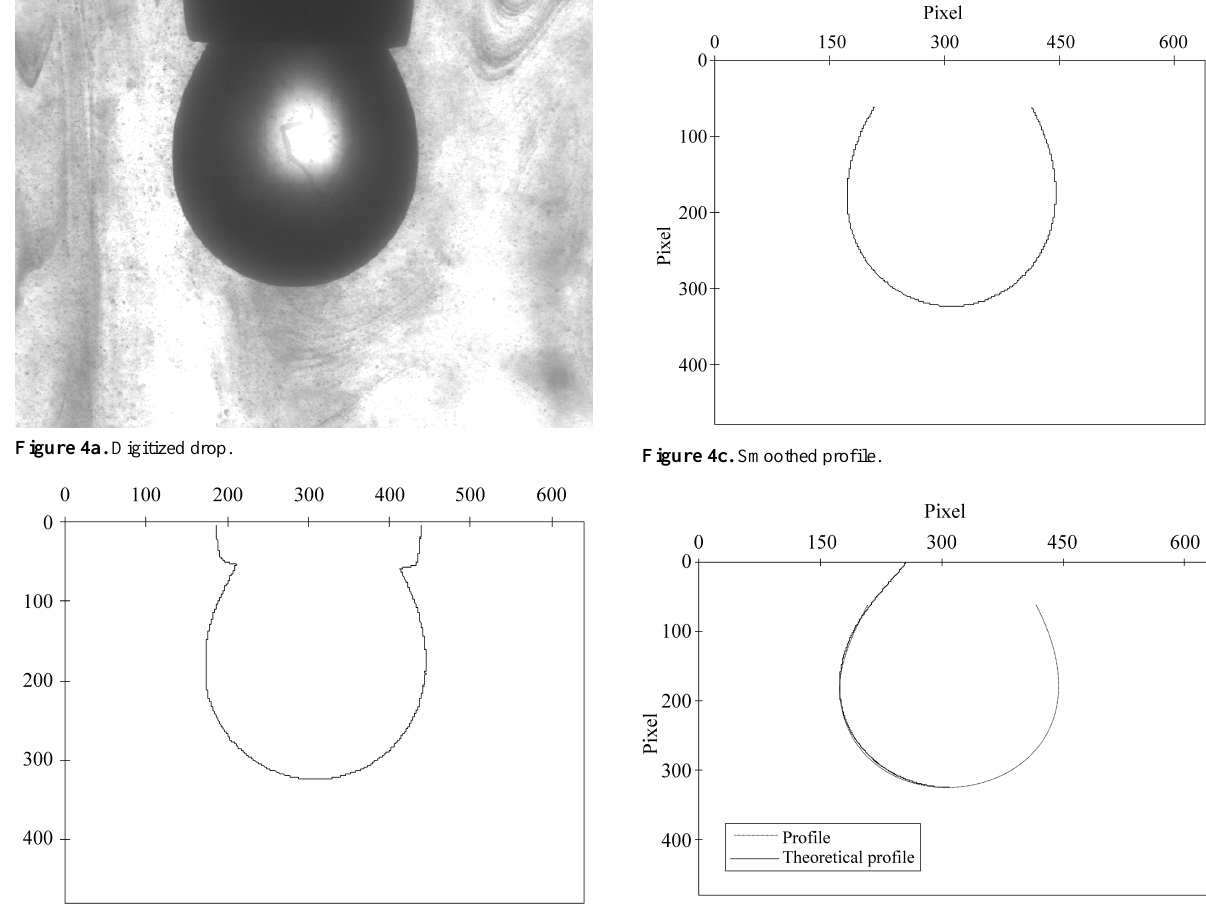
Figure 4b. Edge detection Figure 4. Pendant drop of polystyrene (Mn = 200,000 g/mol) in low density polyethylene at 202